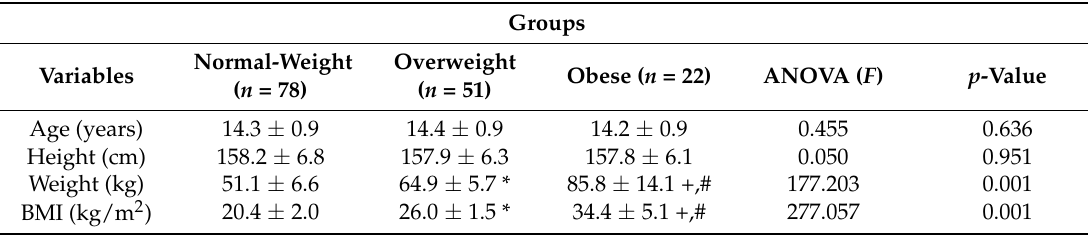
Table 1. Demographic and anthropometric characteristics of